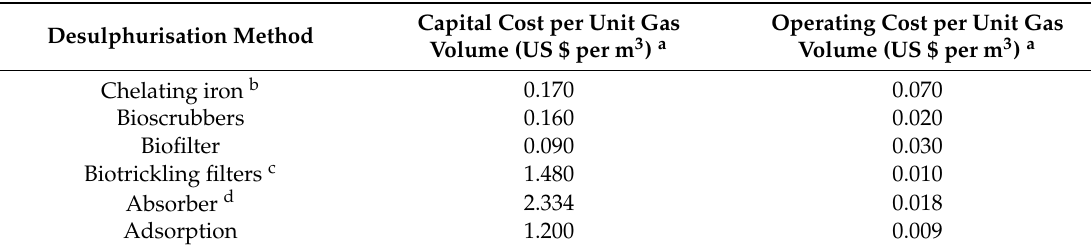
Table 4. Literature obtained economic data for desulphurisation processes of chelating iron scrubbing, bioscrubbers, biofilter, biotrickling filters, absorption, and adsorption technologies